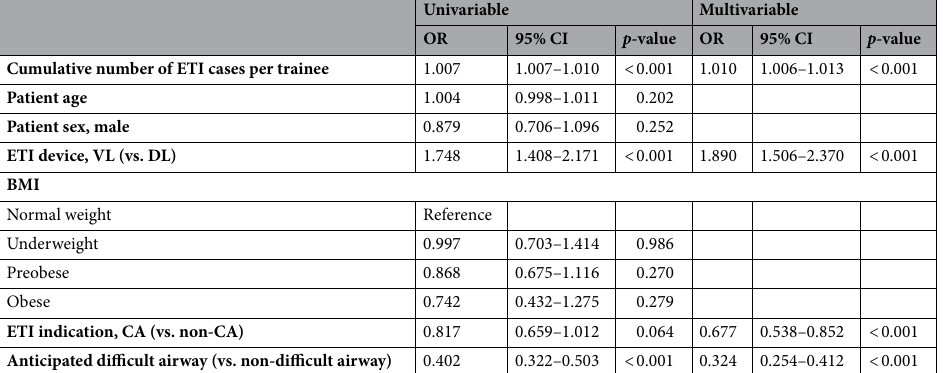
Table 3. Univariable and multivariable analyses to identify the association between FAS and cumulative ETI cases. Generalized linear mixed models with random intercept using the logit link function were used to evaluate the association between FAS and cumulative ETI experience. FAS first attempt success, ETI endotracheal intubation, OR odds ratio, CI confidence interval, VL video laryngoscope, DL direct laryngoscope, BMI body mass index, CA cardiac